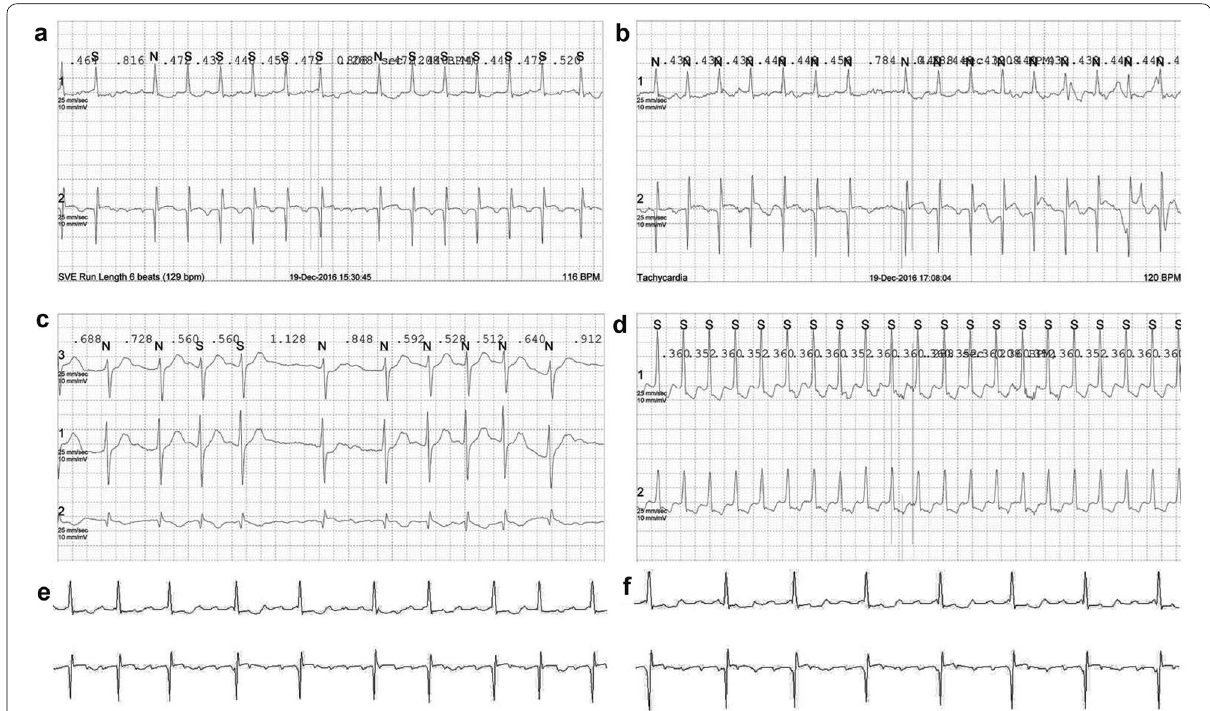
Fig. 2 Example of AF or AT surface ECGs recorded by the Holter. a – d A surface ECG that was judged to be an AT or AF by the Holter, but was not detected as any atrial tachyarrhythmia event on the ILR. e , f A surface ECG that was considered to be an AT on the Holter, but was read as AF by the